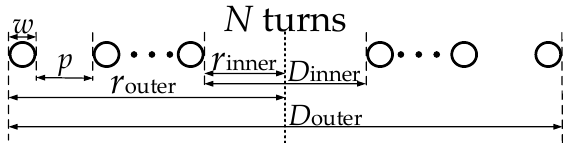
Figure 3. Elevation view of a flat spiral coil.